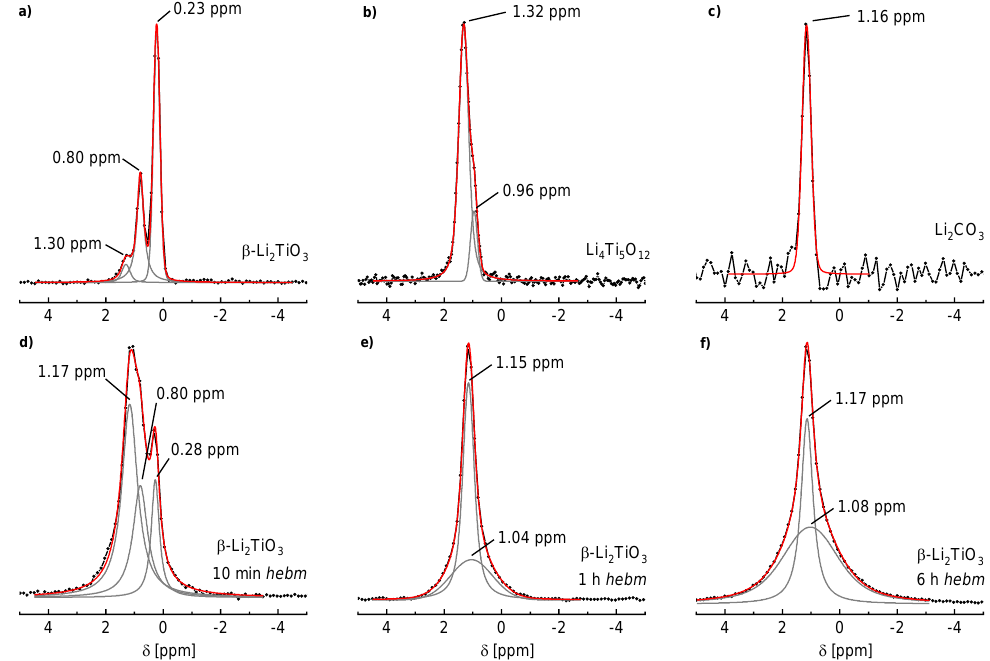
Figure 10. 6 Li SPE MAS NMR spectra of ( a ) β -Li 2 TiO 3 ; ( b ) spinel Li 4 Ti 5 O 12 ; ( c ) Li 2 CO 3 ; ( d ) β -Li 2 TiO 3 after hebm for 10 min; ( e ) 1 h and ( f ) 6 h. All spectra were referenced against solid LiCl and fitted with one, two or three independent Voigt functions with R 2 > 0.99.